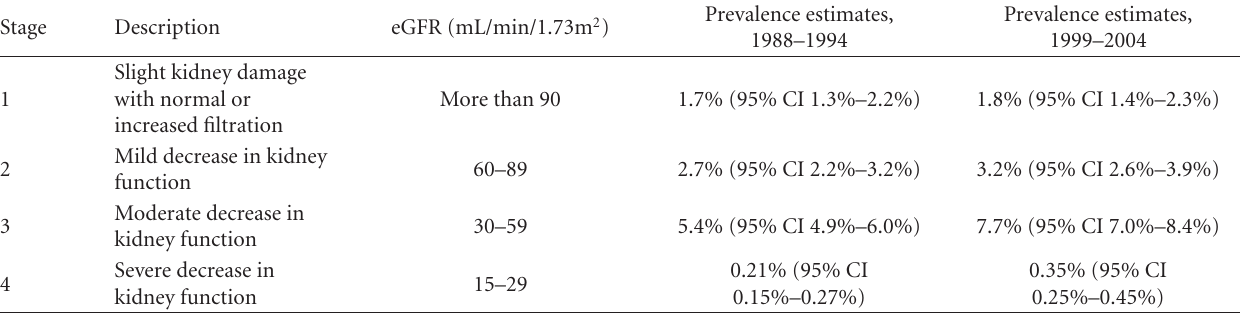
Table 1: Stages of chronic kidney